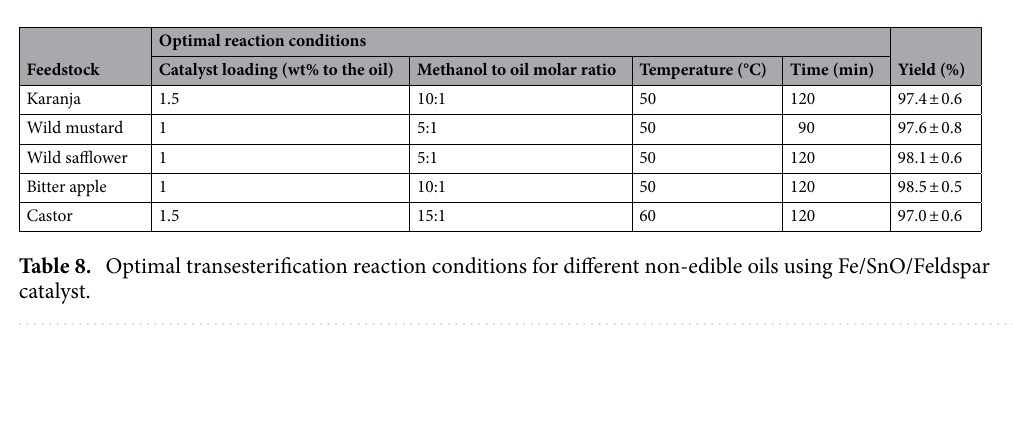
Table 7. Transesterification reaction parameters for castor seed oil.